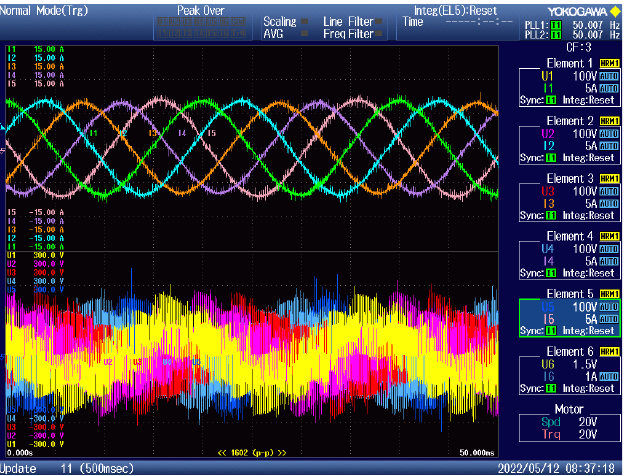
Figure 12. Measured five phase output of the MxC prototype (phase currents—top and phase voltages—bottom).